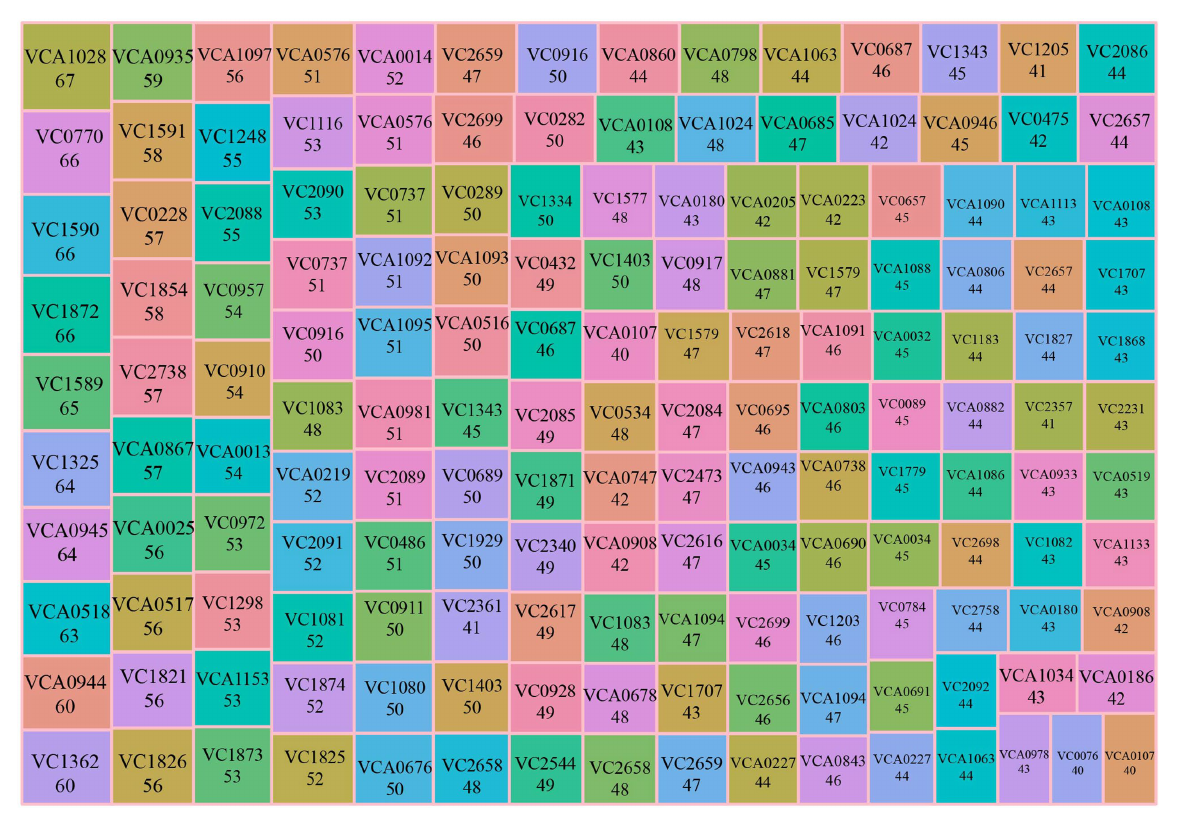
FIGURE 2 Summary of Top 5% differentially expressed genes. The treemap plot summarizes Top 5% differentially expressed genes. The number below the gene name is the number of experimental conditions that the gene was found to be differentially expressed, including up- and down-regulated. Mr.Vc v2 calculates the numbers of the experimental condition of each gene when differentially expressed in experiments, and ranks the corresponding gene by the calculated number of experimental conditions. A total of 161 Top 5% differentially expressed genes were obtained, according to ranking analysis. The Top 5% differentially expressed gene of the last rank was differentially expressed in 40 experimental